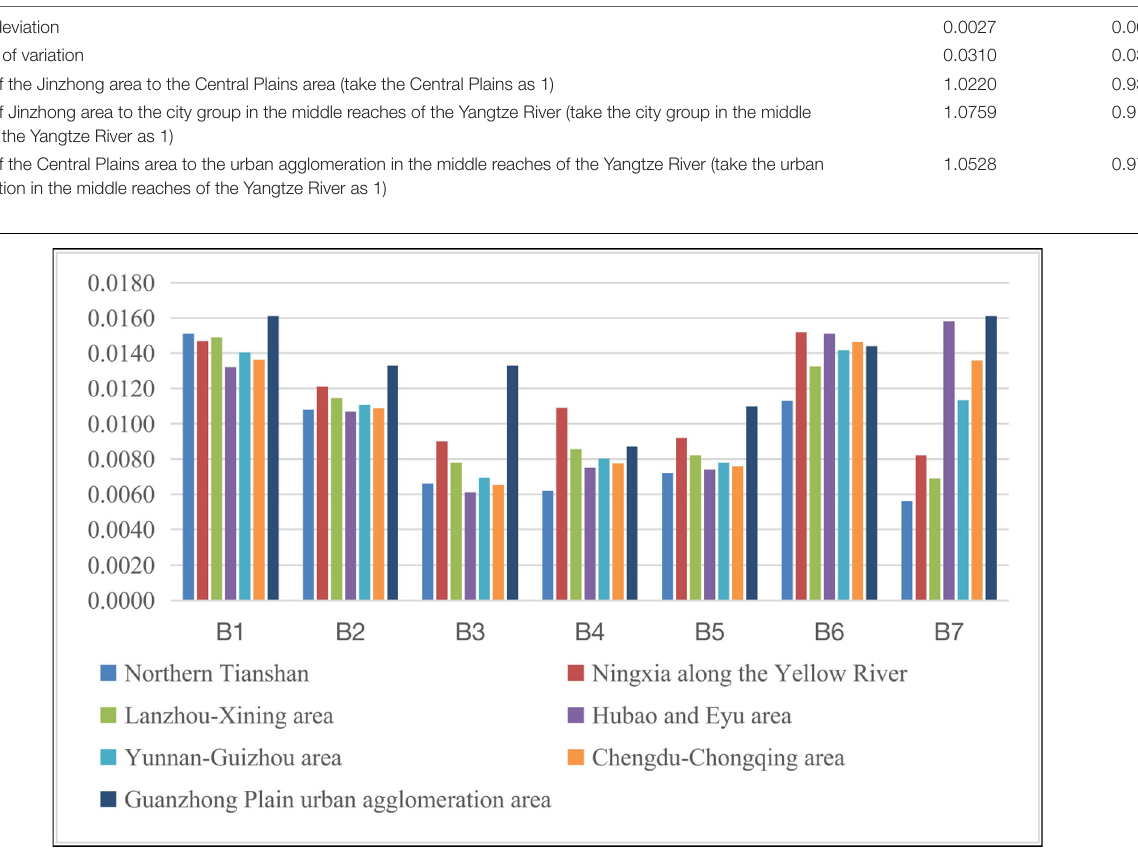
urban agglomeration (Shanghai, Nanjing, Hangzhou, Ningbo), the Pearl River Delta City Cluster (Guangzhou, Shenzhen), Shandong Peninsula urban agglomeration (Ji’nan, Qingdao), city group on the west bank of the Straits (Fuzhou, Xiamen), Beibu Gulf city group (Nanning, Haikou), and Northeast region city group (Harbin, Changchun, Jilin). The social